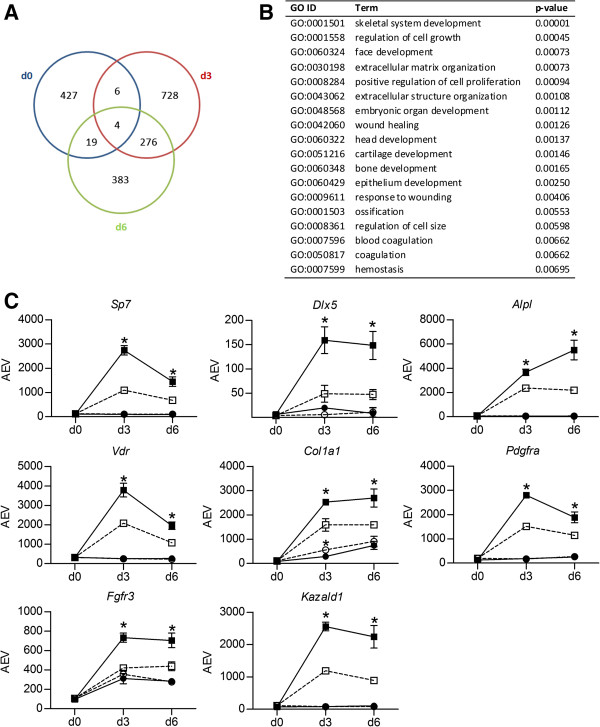
Effect of miR-378 overexpression on C2C12 bone transcription program: upregulation. A) Venn diagram representing the number of probes on the microarray that are significantly (as defined in Methods) higher expressed in C2C12-pMirn378 cells than in control C2C12-pMirn0 cells at each time point during differentiation in the presence of 300 ng/ml BMP2. B) Enriched (p < 0.01) GO terms (in biological processes category) within the set of probes that are significantly higher expressed in C2C12-pMirn378 versus C2C12-pMirn0 cells at at least two consecutive time points during differentiation in the presence of 300 ng/ml BMP2. C) Microarray profiles of bone markers Sp7 transcription factor 7 (Sp7; 1418425_at), distal-less homeobox 5 (Dlx5; 1449863_a_at), alkaline phosphatase (Alpl; 1423611_at), vitamin D receptor (Vdr; 1418175_at), collagen type I alpha 1 (Col1a1; 1423669_at), platelet derived growth factor receptor alpha polypeptide (Pdgfra; 1421917_at), fibroblast growth factor receptor 3 (Fgfr3; 1421841_at) and Kazal-type serine peptidase inhibitor domain 1 (Kazald1; 1436528_at) at indicated time points during differentiation of C2C12-pMirn0 (light bullets) and C2C12-pMirn378 (dark bullets) cells treated with (squares) or without (circles) 300 ng/ml BMP2 as revealed from microarray analysis. Mean expression values +/− SD from triplicate microarray experiments are shown for all data points. When the error bar is not visible, the SD falls within the printed data point. All SD values are, however, listed in Additional file 2. AEV = average expression value; *significantly different expression in C2C12-pMirn378 compared to control C2C12-pMirn0 at the same time point and treatment (see Methods for definition).